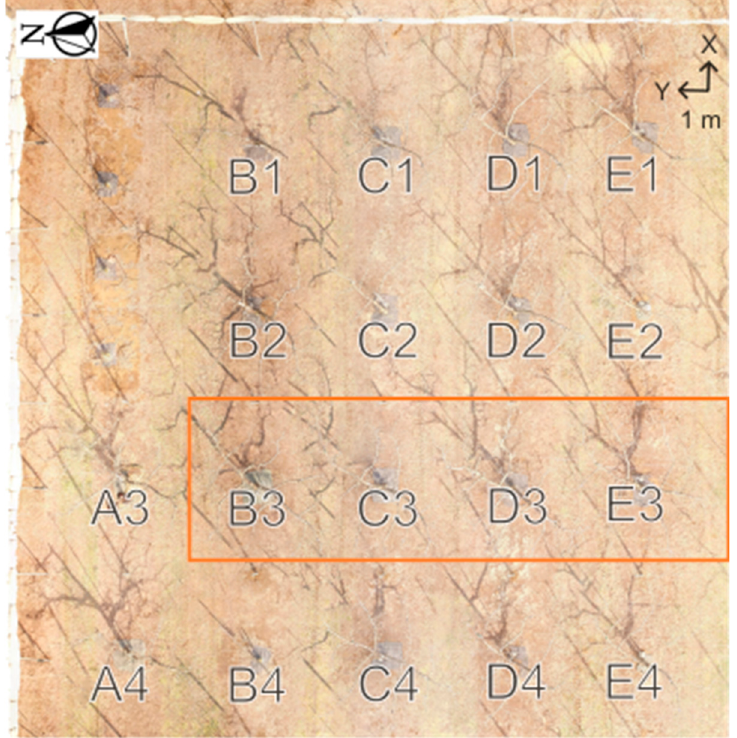
Figure 2. Job block introduction using the image taken by UAV-SfM. The orange block was used to illustrate the difference between 3D lidar SLAM and UAV-SfM and the classification method of the branches. A3–E4 represent the ID of tree.